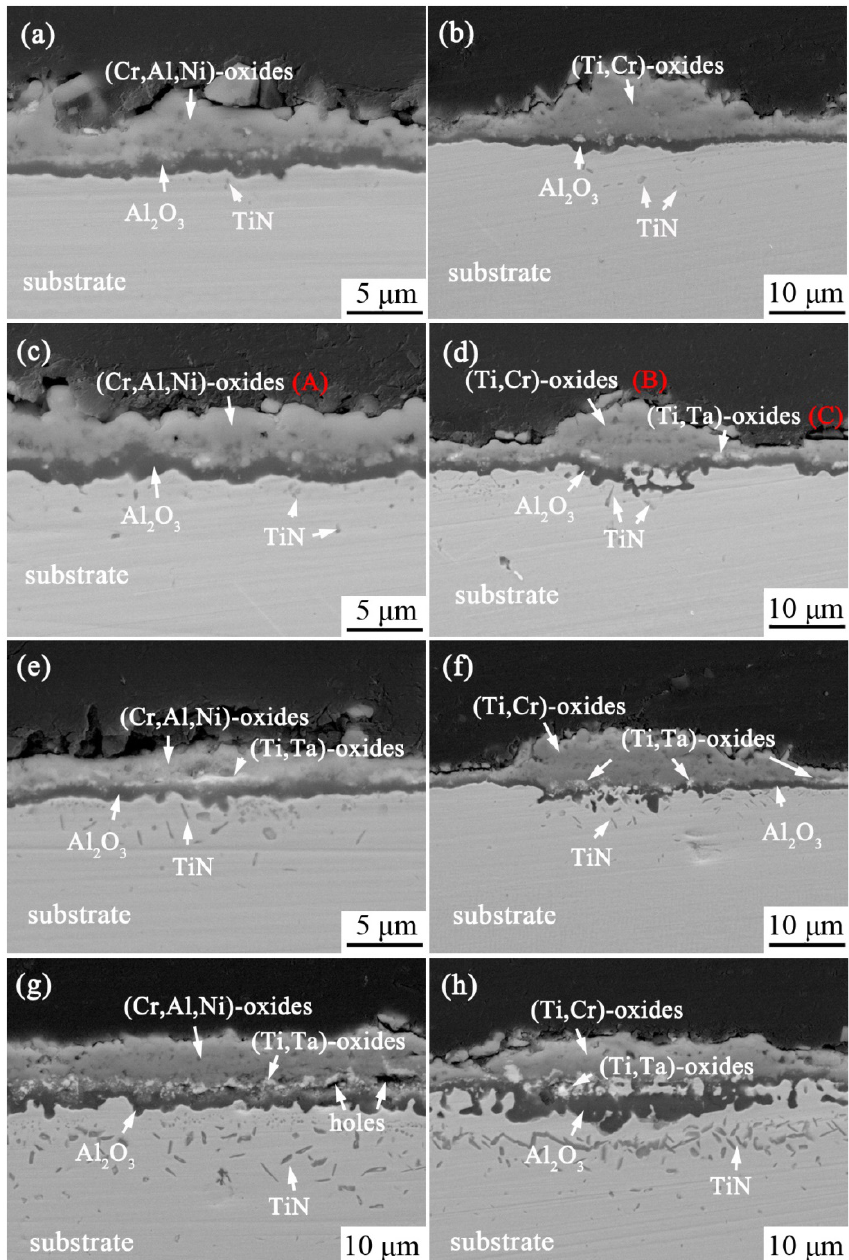
Figure 9. Cross-section morphologies of the oxide scales formed on the E7, E71, E73 and E75 alloys after oxidation at 1000 °C for 100 h. ( a ), ( c ), ( e ) and ( g ): Flat surface regions on the E7, E71, E73 and E75 alloys at 100 h, respectively. ( b ), ( d ), ( f ) and ( h ): Oxides clusters on the E7, E71, E73 and E75 alloys at 100 h, respectively. “A””B””C” represent the products at which it is labeled. The products information corresponding to “A””B””C” is listed in Table 3.